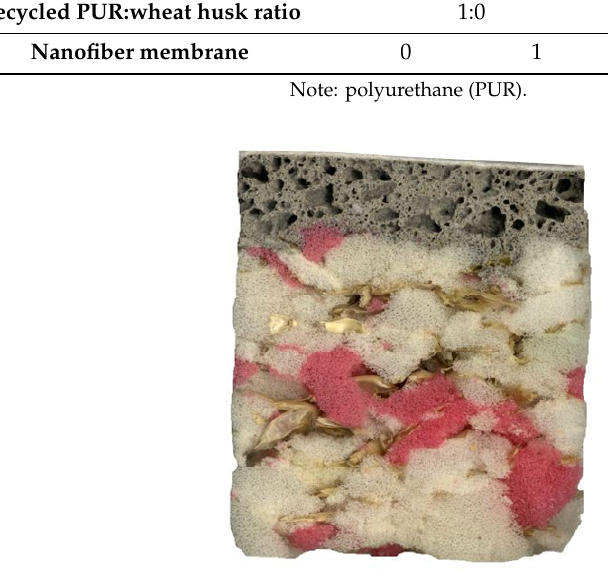
Figure 2. View of sandwich panel cut.